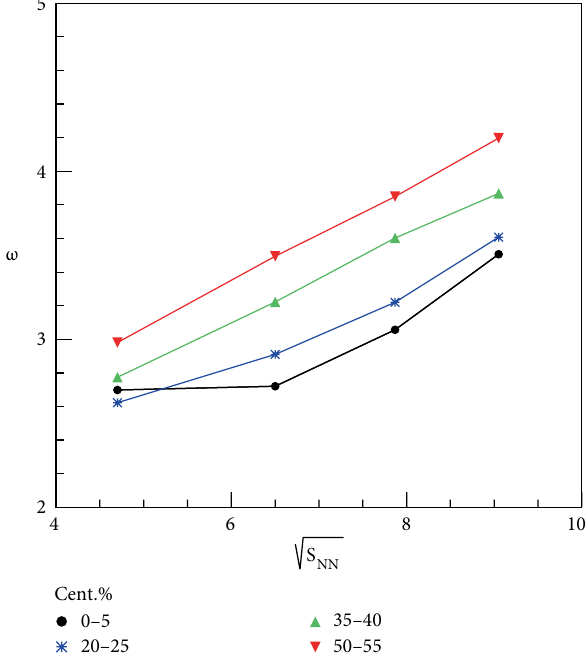
Figure 6: Scaled Multiplicity distributions of relativistic charged particles for the centrality bins 0–10%, 30–40% and 50–60%. Distributions corresponding to 30–40% and 50–60% are shifted upwards on the y-scale by factors 10 and 100 for clarity sake only.